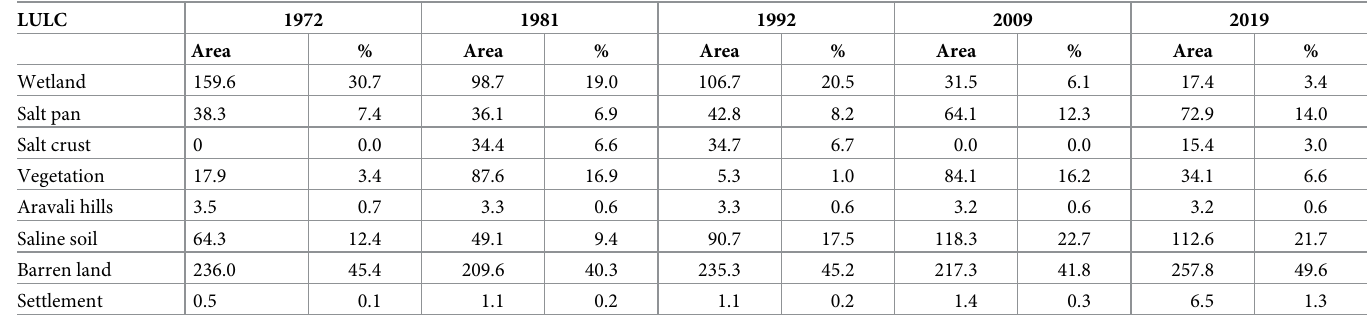
Table 2. LULC change area from 1972–2019 (area in km 2 ).